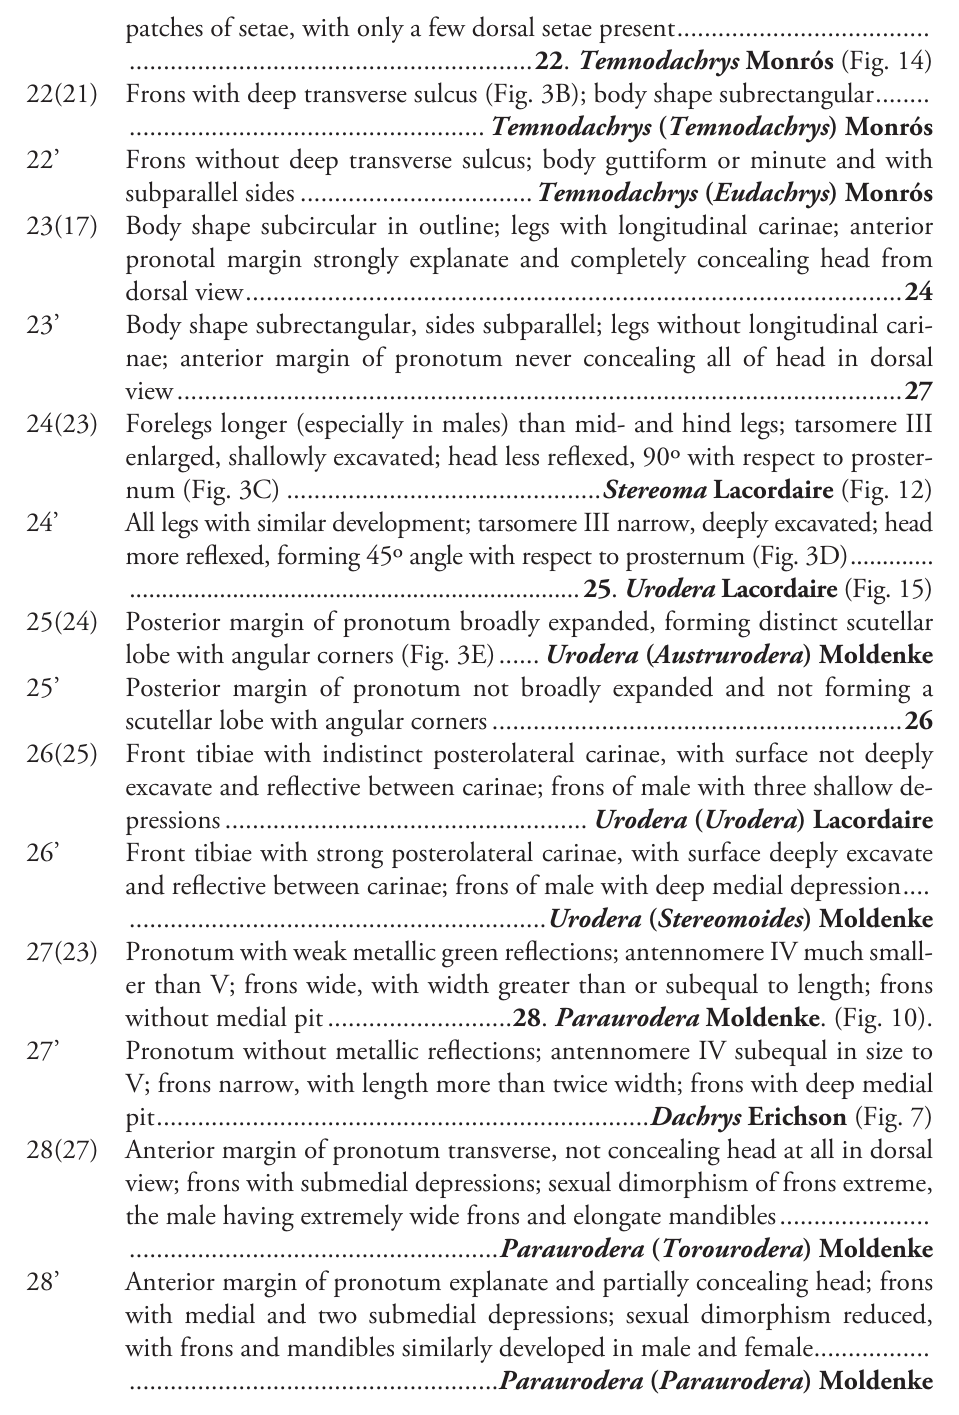
Frons with deep transverse sulcus (Fig. 3B); body shape subrectangular ........ Frons without deep transverse sulcus; body guttiform or minute and with Body shape subcircular in outline; legs with longitudinal carinae; anterior pronotal margin strongly explanate and completely concealing head from 23’ Body shape subrectangular, sides subparallel; legs without longitudinal cari- nae; anterior margin of pronotum never concealing all of head in dorsal 24(23) Forelegs longer (especially in males) than mid- and hind legs; tarsomere III enlarged, shallowly excavated; head less reflexed, 90º with respect to proster- num (Fig. 3C) .............................................. Stereoma Lacordaire (Fig. 12) 24’ All legs with similar development; tarsomere III narrow, deeply excavated; head more reflexed, forming 45º angle with respect to prosternum (Fig. 3D) .............